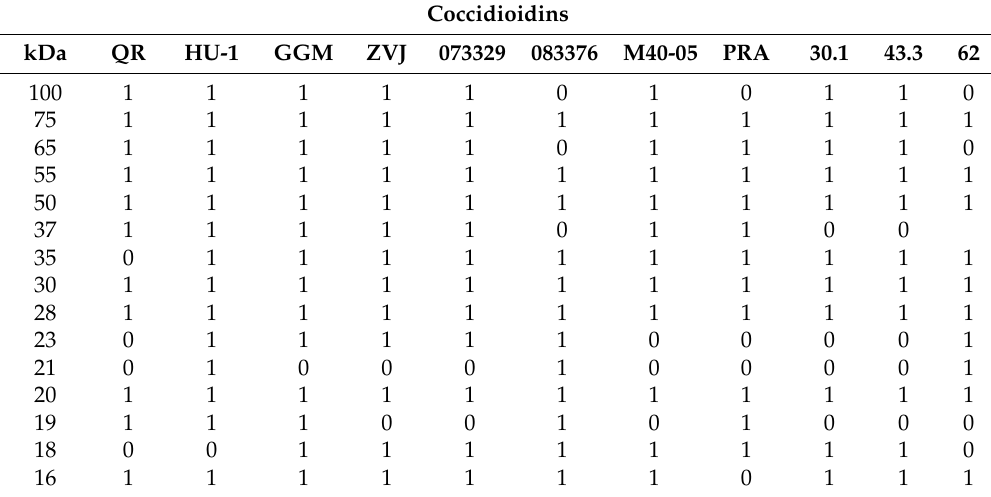
Figure 2. Electrophoresis (SDS-PAGE) of coccidioidins of C. immitis and C. posadasii . The molecular weight of each band of the protein pattern was analysed with Quantity One ® 1-D Analysis software (Bio-Rad). A concentration of 12% polyacrylamide was used. M: Molecular size marker (250 kDa). Table 1. Matrix of presence/absence of bands in the electrophoretic patterns of coccidioidins of C. immitis and C. posadasii.